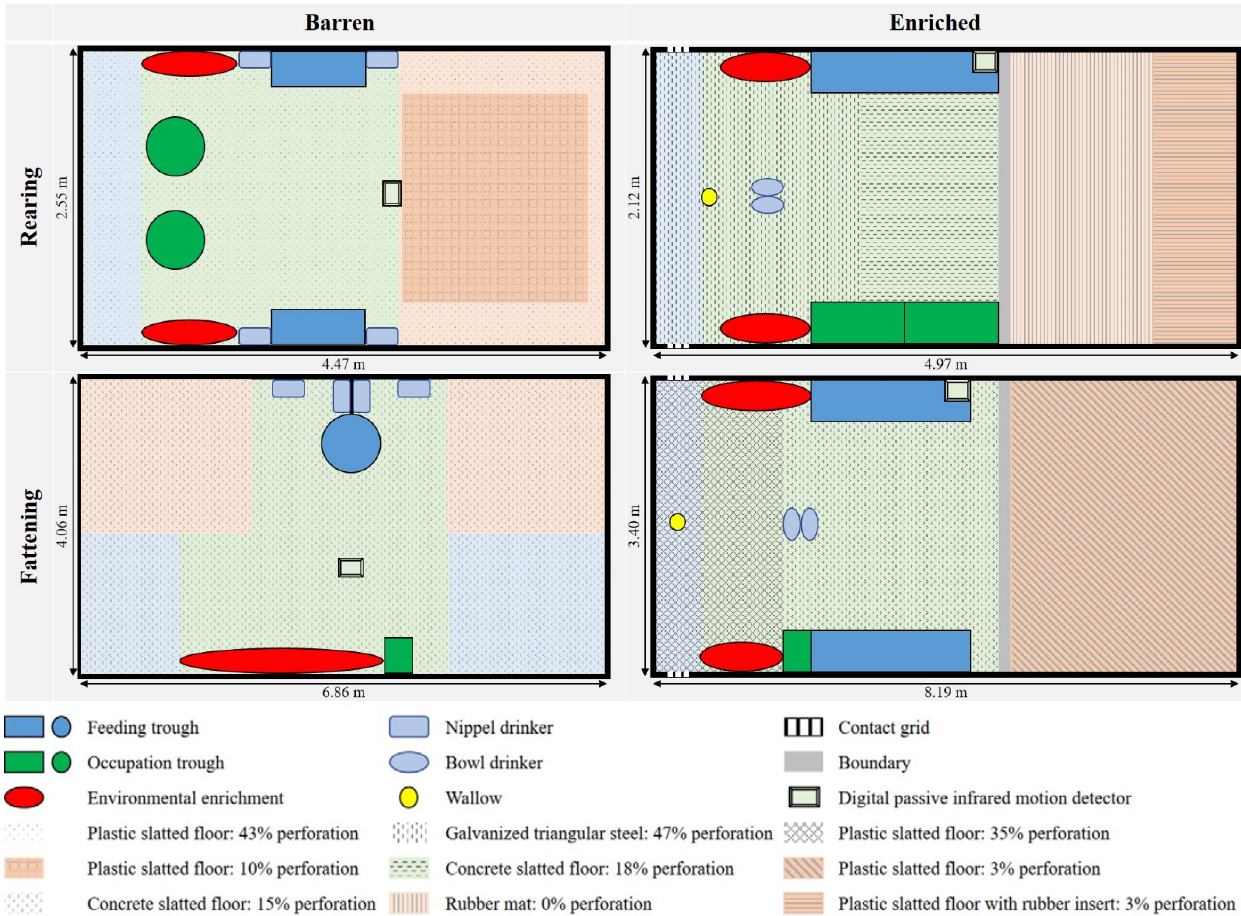
Figure 1. Illustration of the barren and enriched pens in rearing and fattening. The colours indicate the pen structure: blue for the faeces area, green for the activity area and orange for the lying area.